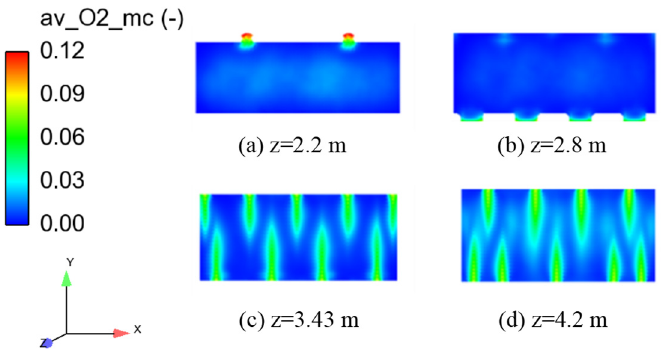
Figure 8. Distributions of oxygen concentration in cross-sections of dense phase zone in Case 1 (( a )—returning port; ( b )—fuel-feeding port; ( c )—lower secondary air; ( d )—upper secondary air).